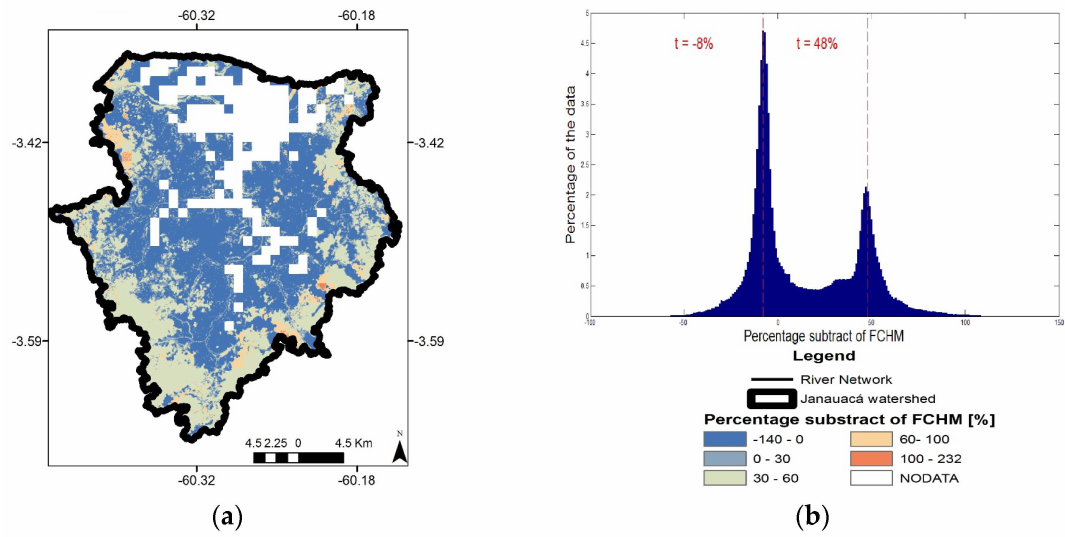
Figure 5. ( a ) Percentage subtracted from map of Forest Canopy Height (FCHM) deduced from the difference between the SRTMGL1 and DEM_COR, and associated ( b ) histogram restricted to the watershed of DEM_COR (For interpretation of the references to color in this figure legend, the reader is referred to the web version of this